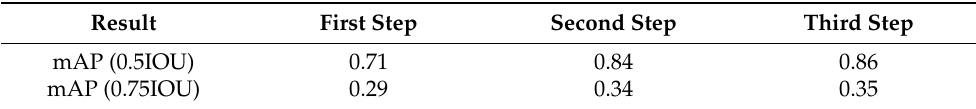
Table 1. Crack detection